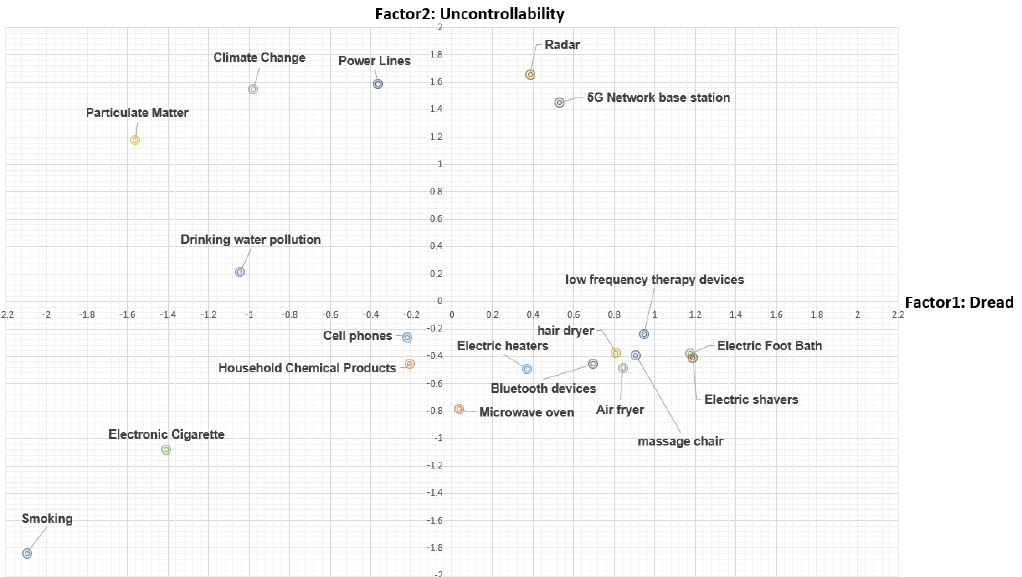
Figure 3. Risk cognitive map on electromagnetic fields around the public.